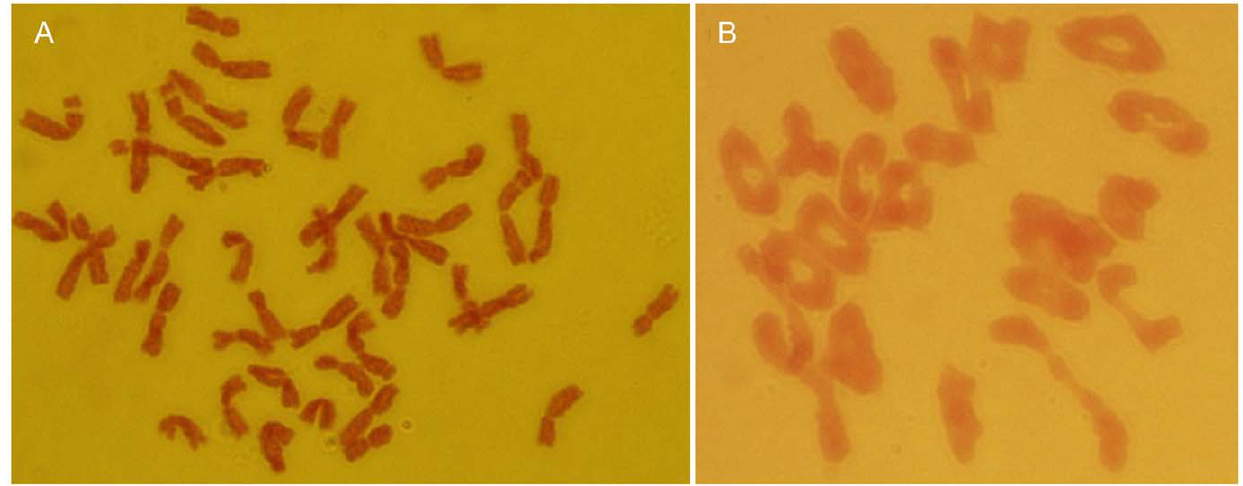
Figure 2. Mitotic and meiotic patterns of the wheat- Psathyrostachyshuashanica addition line 59-11. a Somatic chromosomes in root tips, 2 n =44; b Chromosome behavior of PMCs at metaphase I, 2 n =22 II.